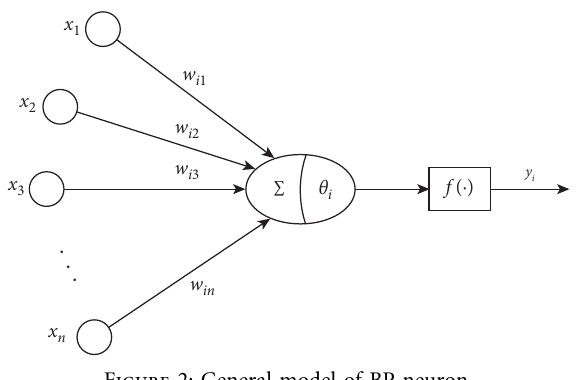
Figure 2: General model of BP